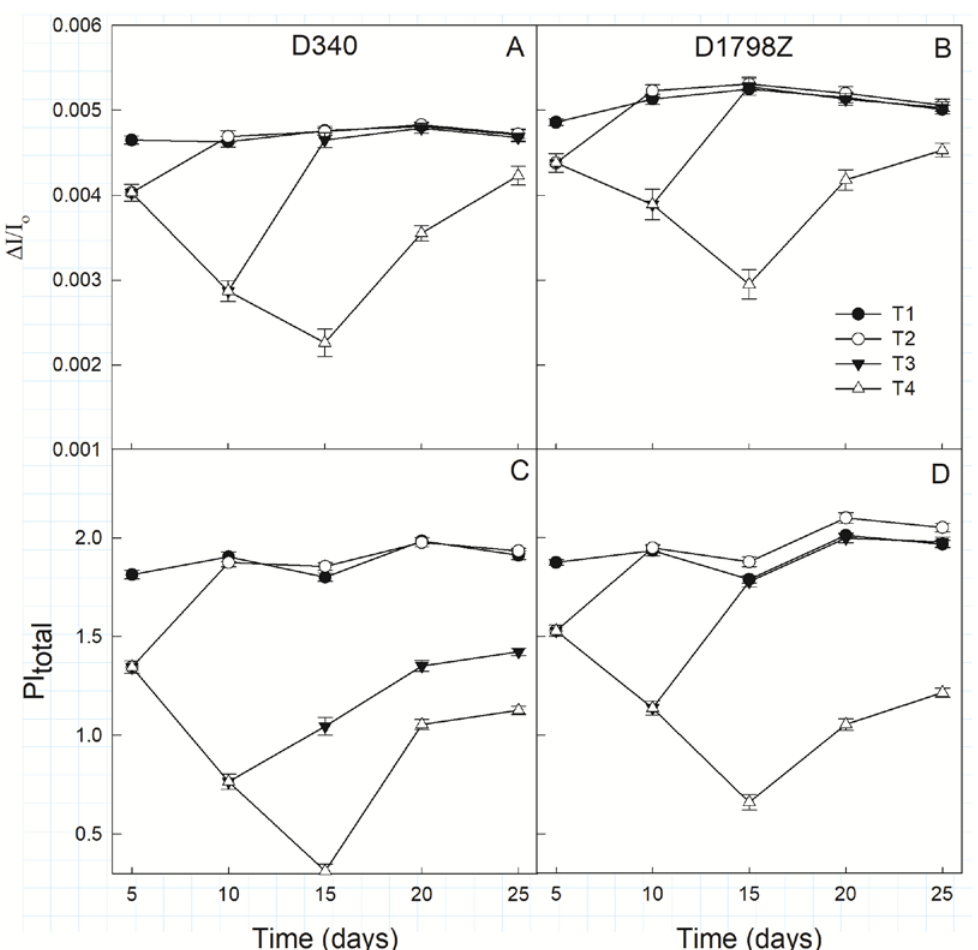
Figure 7. E ff ect of di ff erent drought durations and re-watering on ∆ I / Io, Maximum photochemical Figure 7. Effect of different drought durations and re- watering on ΔI/Io , Maximum photochemical activity of photosystem I ( A , B ) and PI total , the total PI ( C , D ) of two maize lines. Each parameter is the activity of photosystem I ( A – B ) and PI total , the total PI ( C – D ) of two maize lines. Each parameter is the average of three average of three replicates.